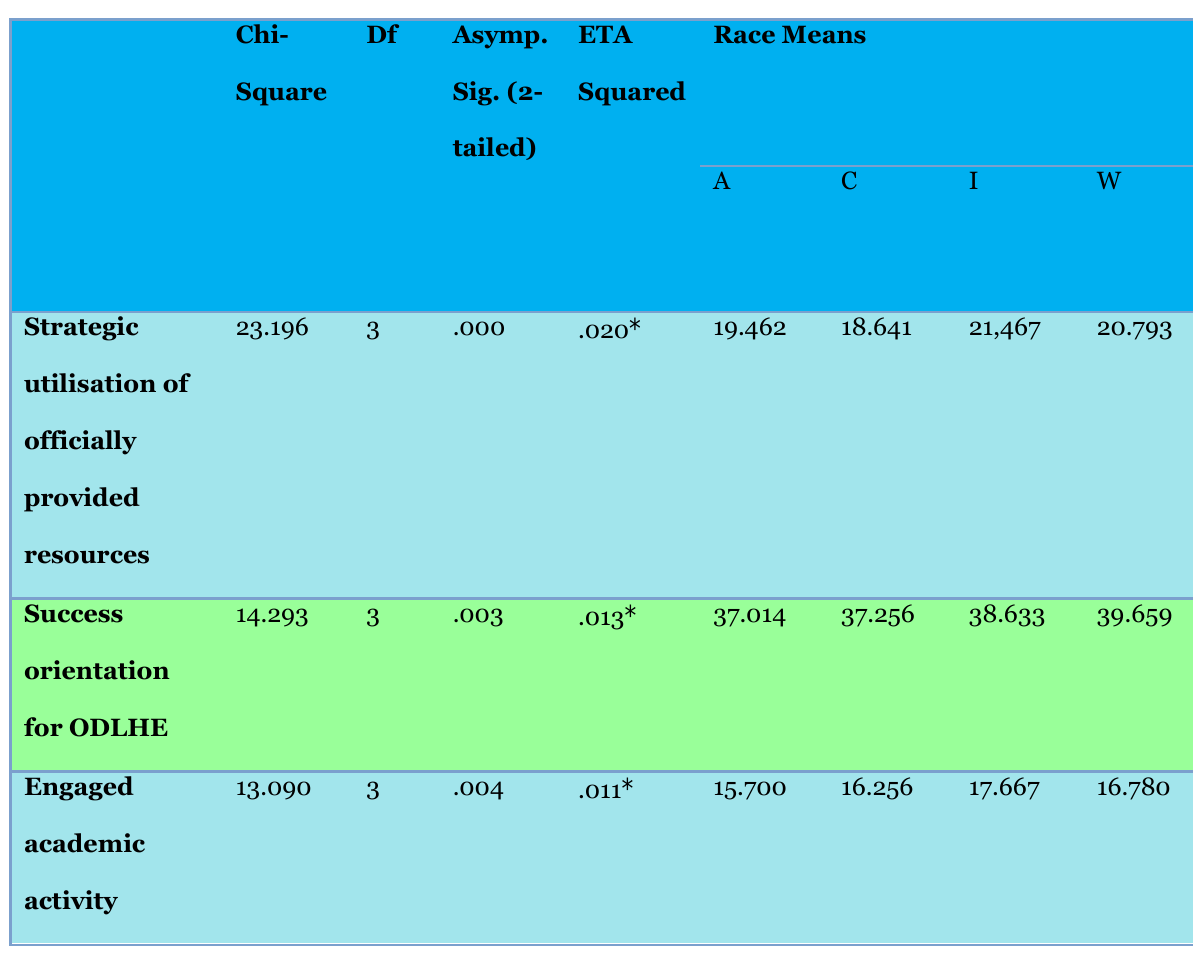
Results of the Kruskall-Wallace Test: Race